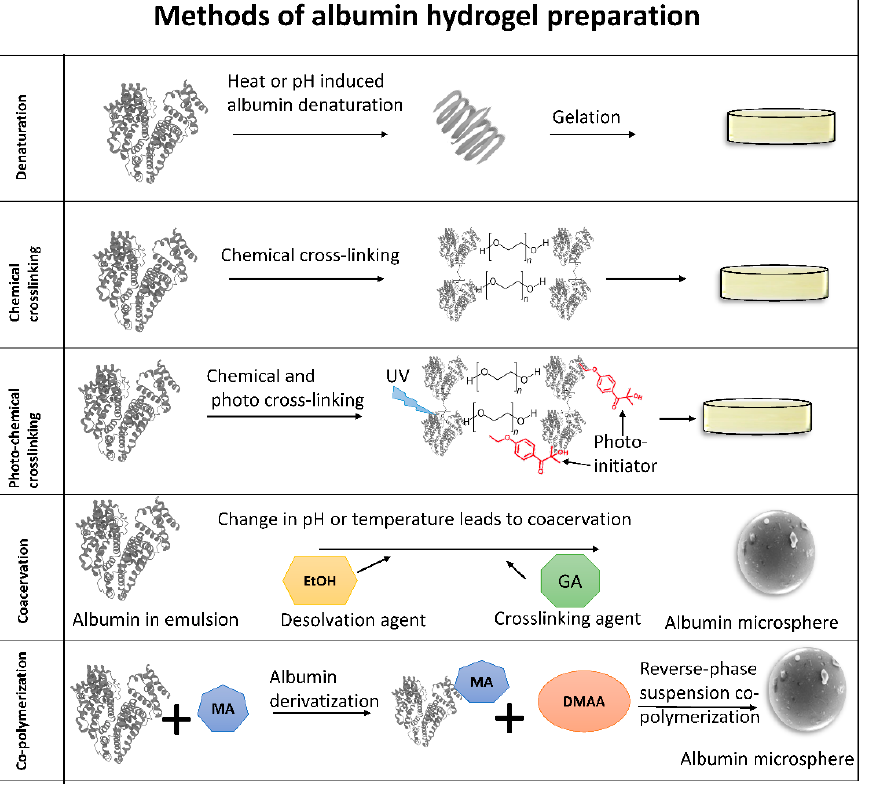
Figure 3. Albumin hydrogel fabrication and applications. Various strategies are available to induce gelation in albumin, and they have various applications in medicine. For chemical/photocrosslinking, albumin is first acylated and then the double bonds are cross-linked either thermally or photochemically. MA: methacrylic anhydride, DMAA: N,N-dimethyacrylamide, GA: glutaraldehyde, EtOH: ethanol, UV: ultraviolet.